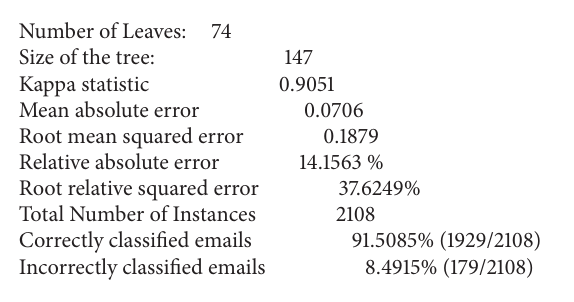
Algorithm 4: Summary of classification result.